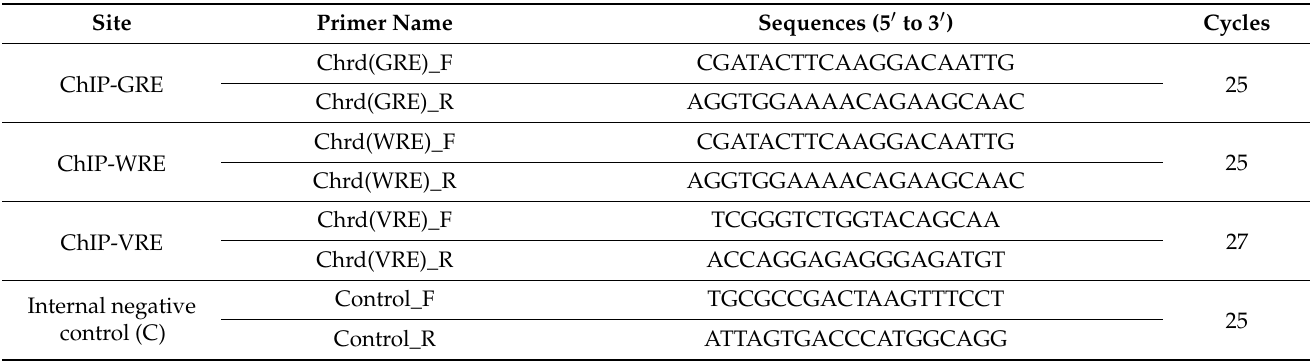
Table 4. Primers used for ChIP-PCR